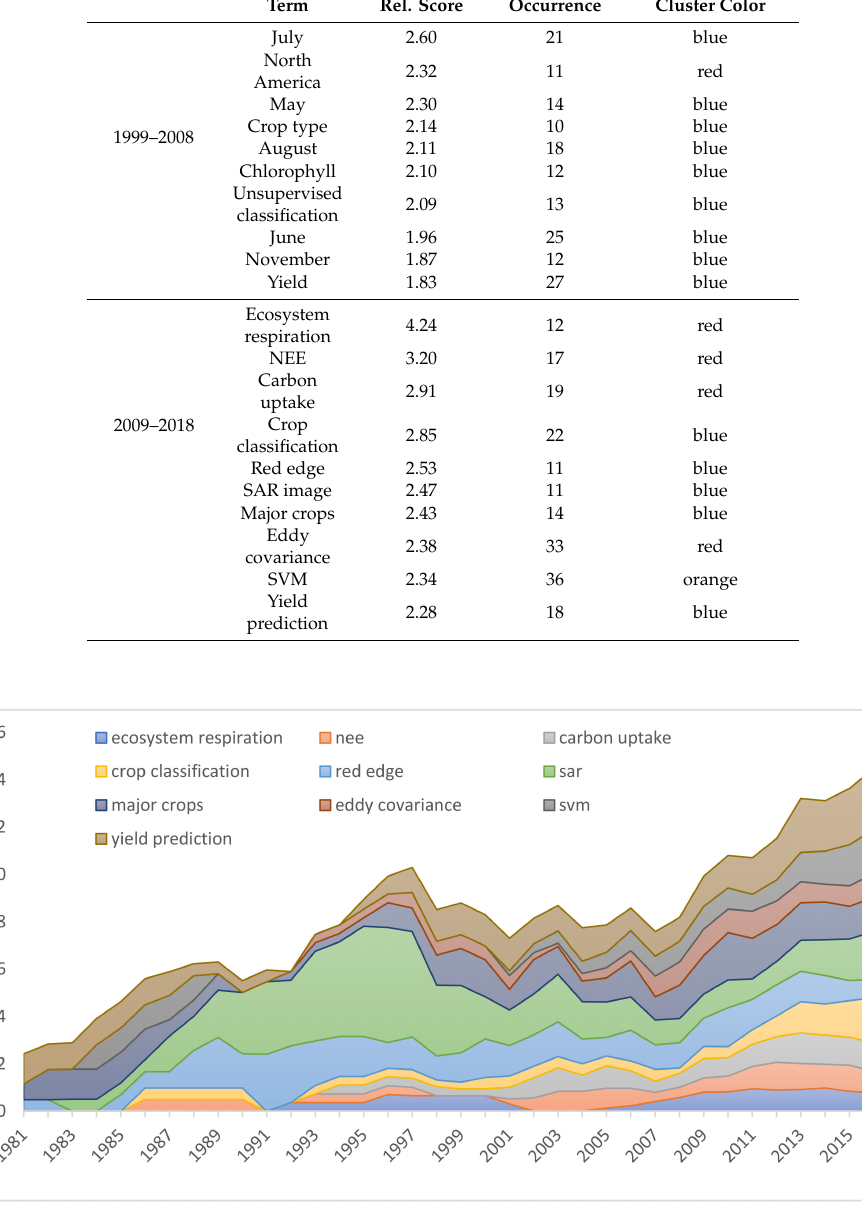
Figure 7. Temporal trend and proportion of the rs + pheno papers dealing with the ten most relevant terms identified in 2009–2018 (see Table 3) to the total rs + pheno papers over the period 1979–2018. A 5-year moving average was